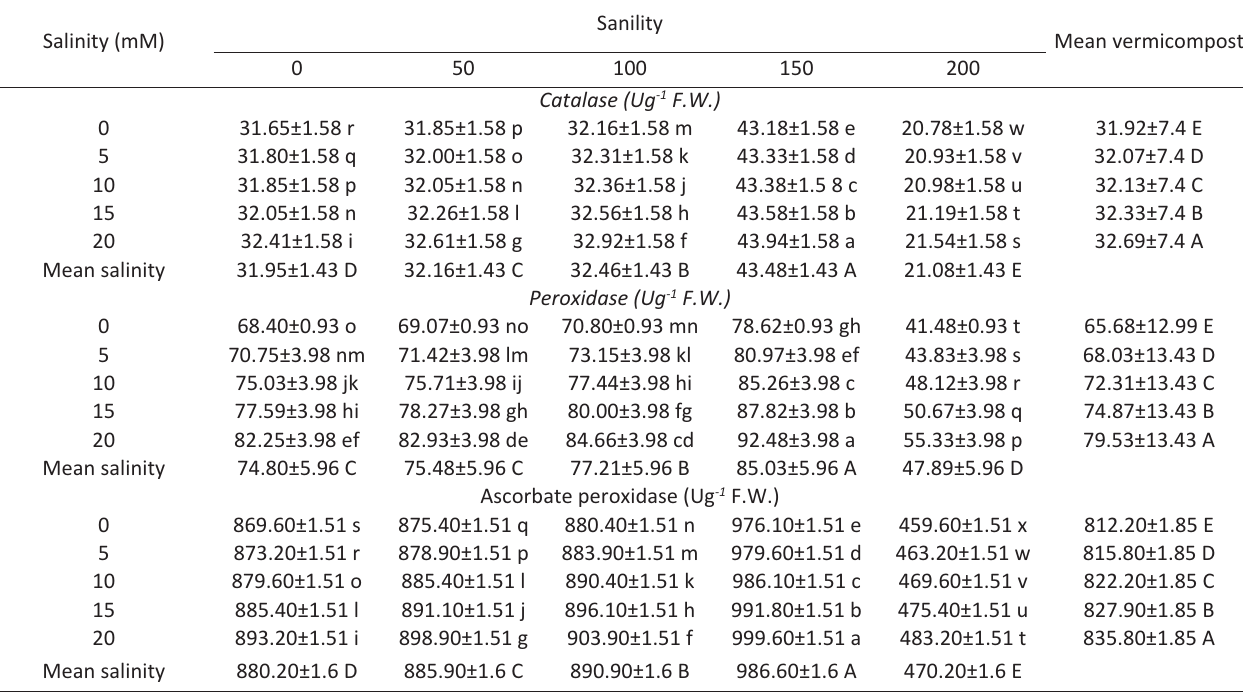
* In each variable, data followed by the same letters (small letters for interactions and capital letters for means) are not significantly dif- ferent using LSD at 5%level. Data represent the mean value ± S.D. the mean of four